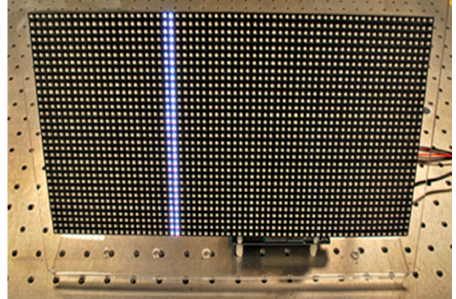
Figure 3. Prototype pseudo-moving target created by LED lines marching across the array.